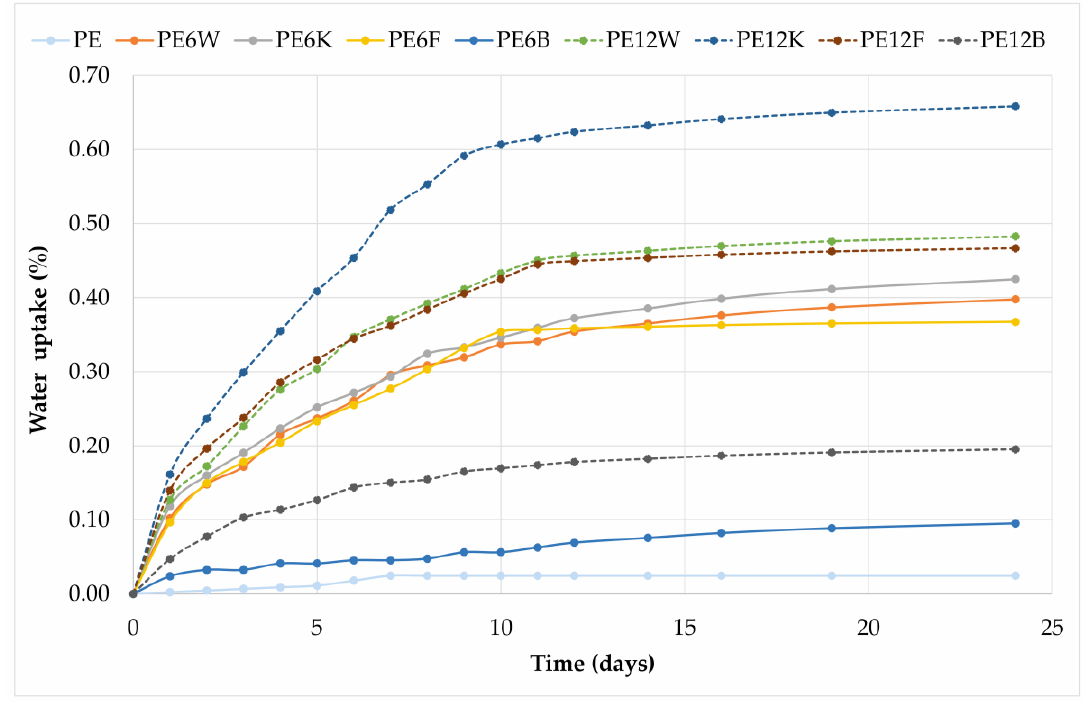
Figure 9. Water absorption of tested composites. Table 5. Mechanical properties measured after water and thermal ageing.